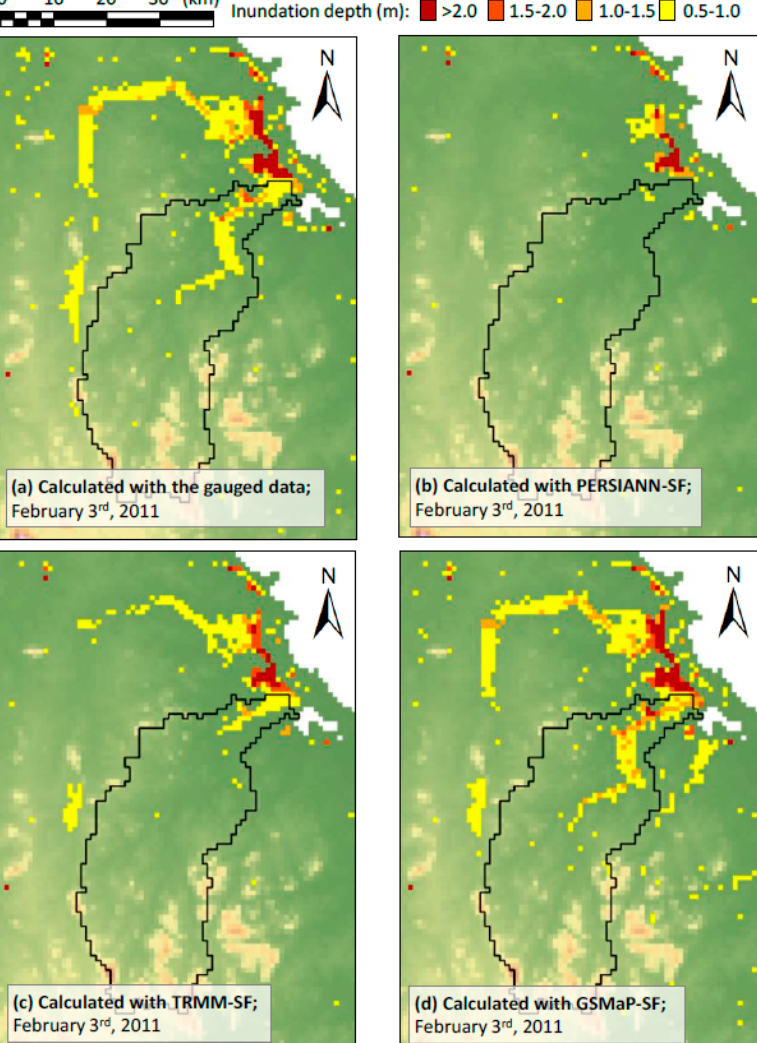
Figure 7. Distribution of flood inundation depth on 3 February 2011, calculated by the calibrated RRI model; ( a ) Gauged-R; ( b ) PERSIANN-SF; ( c ) TRMM-SF; and ( d ) GSMaP-SF. Table 7. Coincidence of inundation extent for the peak flooding times and the entire flooding periods. Coincidence ( Φ peak and Φ total ) was defined by Equations (8) and (9). The larger Φ peak and Φ total are more related to the flood inundation extent between the SREs and the Gauged-R data.